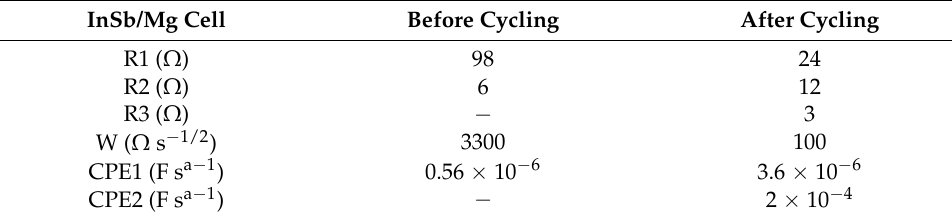
Figure 2. Nyquist plots obtained ( a ) before and ( b ) after cycling of InSb/Mg cells. The corresponding equivalent circuit for fitting the plots is depicted in each figure. The equivalent circuit parameters: R1, R2, R3, and W correspond to the ohmic resistance, interface resistance, charge-transfer resistance, and Warburg (cation diffusion) resistance, respectively. CPE1 and CPE2 represent constant phase elements associated with R2 and R3, respectively. The fitting factors ( χ 2 /|Z|) obtained from the EIS before and after cycling are 0.012 and 0.013, respectively. Table 1. Fitting parameters of the Nyquist plots for InSb/Mg